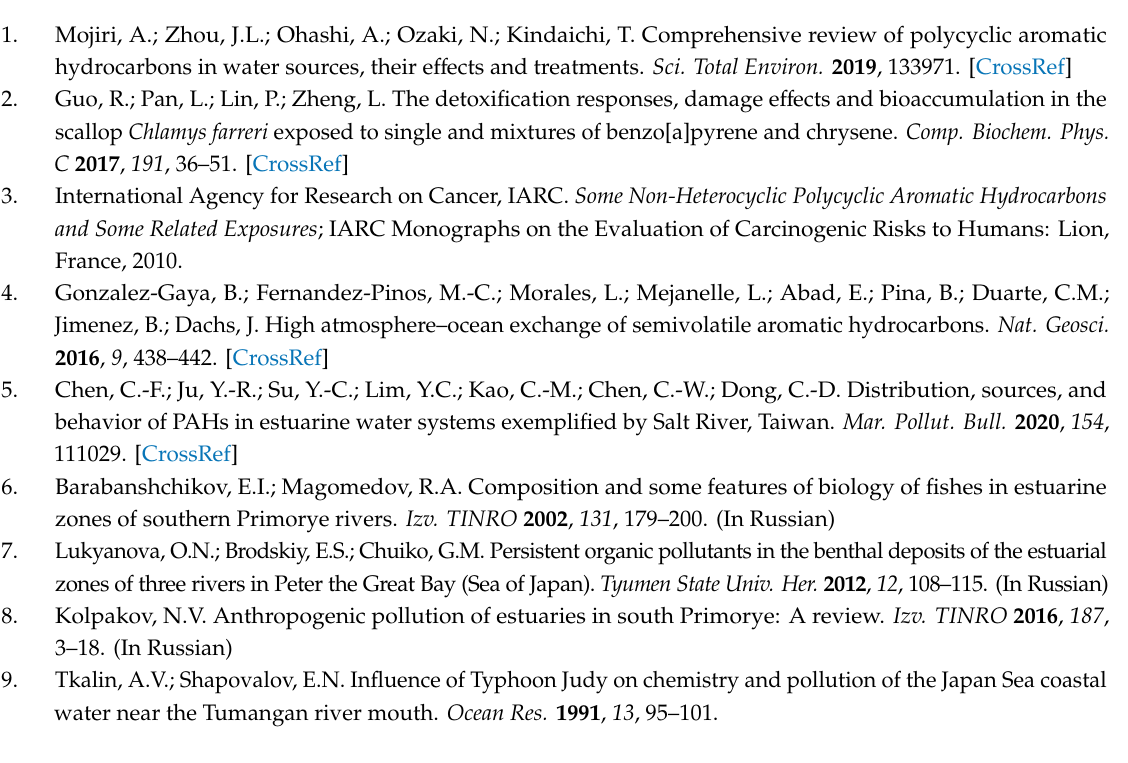
Figure S1: Relationship between the mean TPAHs concentration and the daily discharge in the Tumen River estuary (a) and the Partizanskaya River estuary (b), Figure S2: (A)—Relative abundance of DPAHs in the Tumen River (left) and Partizanskaya River (right); (B)—Relative abundance of PPAHs in the Tumen River (left) and Partizanskaya River (right), Table S1: The quality values of NCs and MPCs for studied compounds taken from